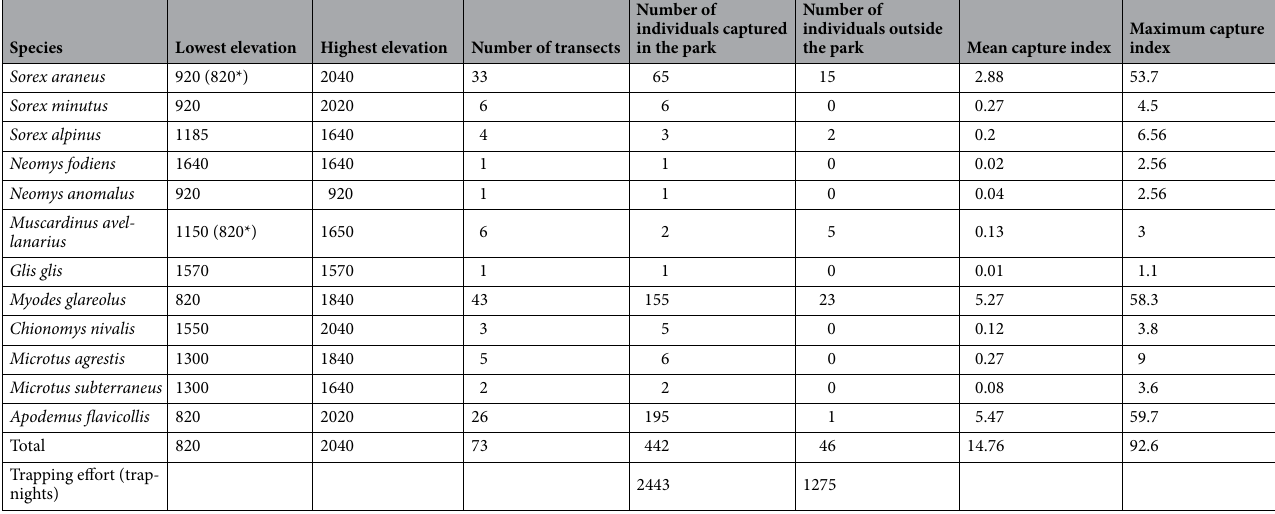
Table 1. Results of small mammal trapping during the 5 years of survey. *indicates data based on accidental visual observations, not included in the analyses. Trapping in the park was conducted every year but outside the park it was done mostly in 2003 and 2005 (with only one transect in 2004), both years with low abundances of the dominant rodents, hence the low number of captured individuals outside the park. Minimum capture index for each species is